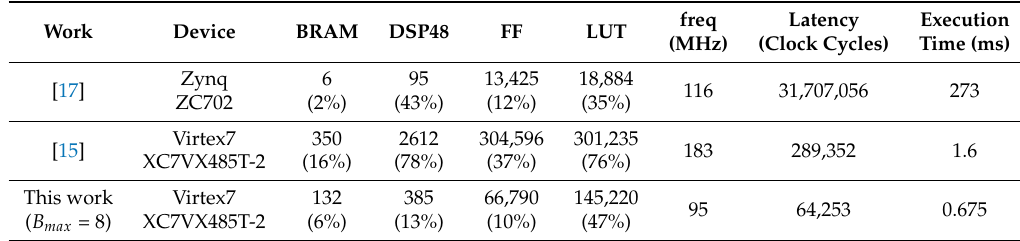
Figure 17. Energy distribution of the eigenvalues for the Hyperspectral Imaging (HI) data set. Table 4. Comparison of our PCA accelerator with other conventional methods. The input data dimensions are set to 30 × 16 for all